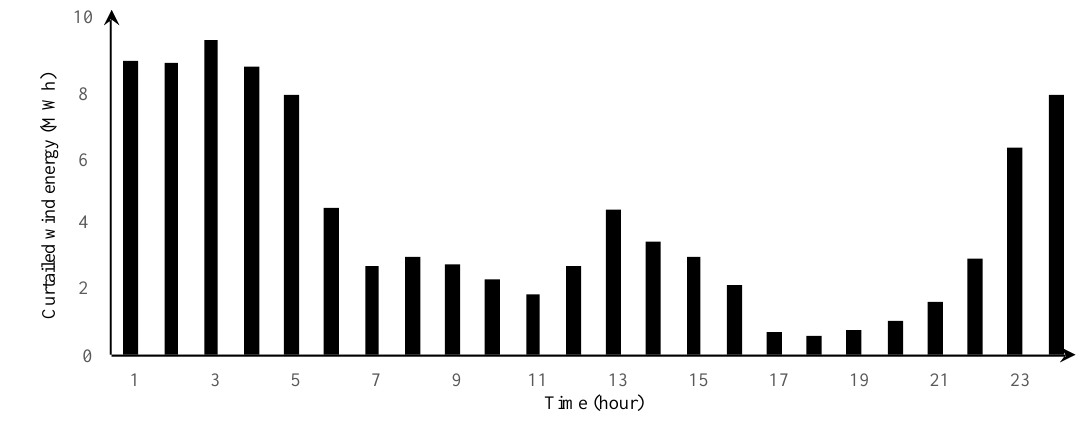
Figure 10. The hourly curtailed wind energy during heating